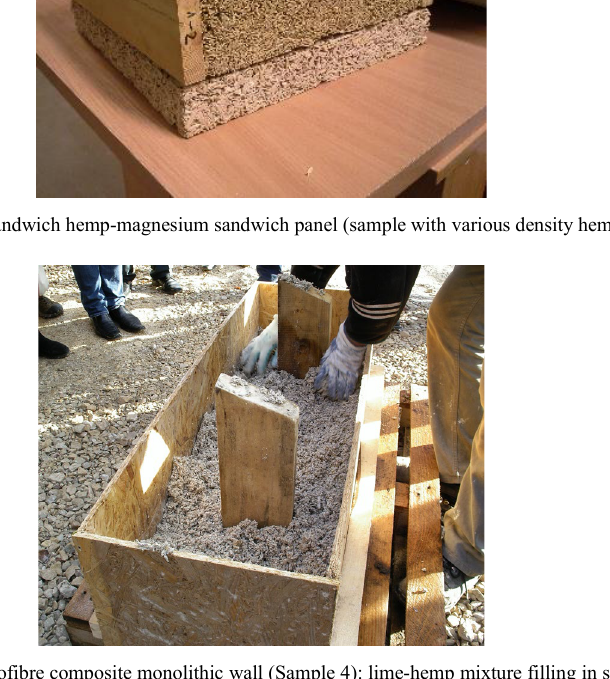
Fig. 6. Lime based hemp biofibre composite monolithic wall (Sample 4): lime-hemp mixture filling in sliding formwork. Hemp Eco Systems Latvia Ltd. Workshop.